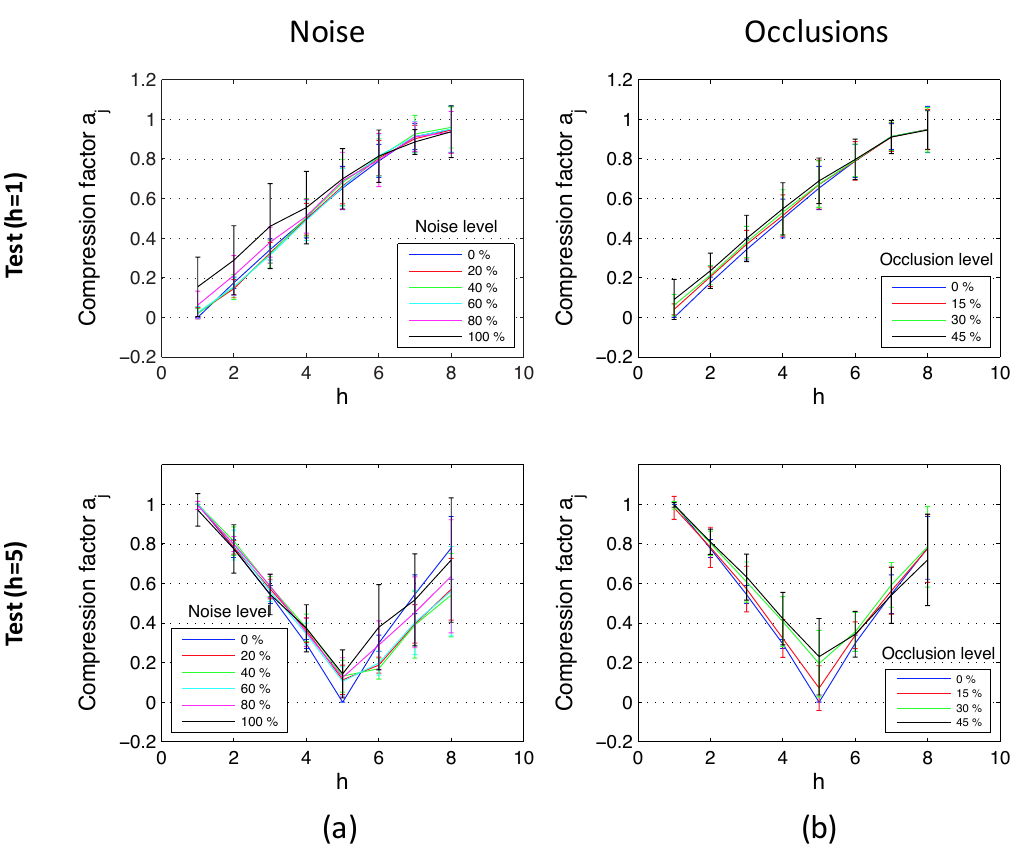
Figure 15. Altitude estimation using the database captured in indoor environments, using reference images at the bottom (h = 1) and in the middle of the height (h = 5). Average and standard deviation of all locations considering ( a ) the original test images, ( b ) noise added to the test images, and noise + occlusions added to the test